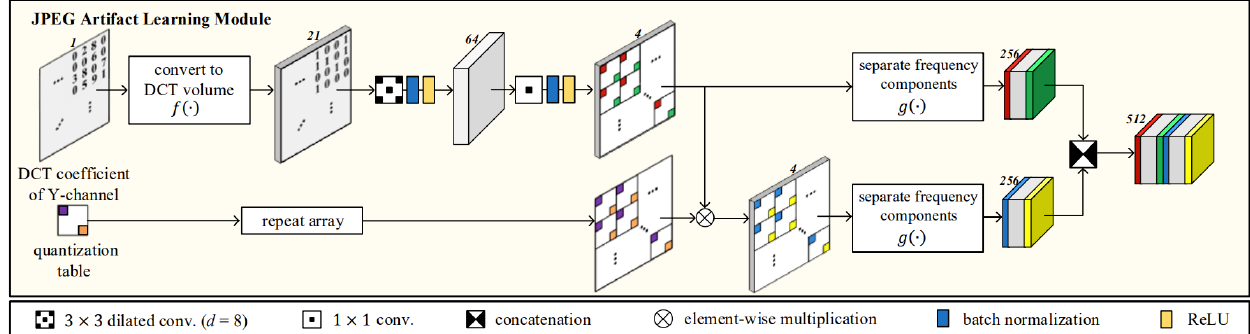
Figure 3. JPEG artifact learning module architecture.